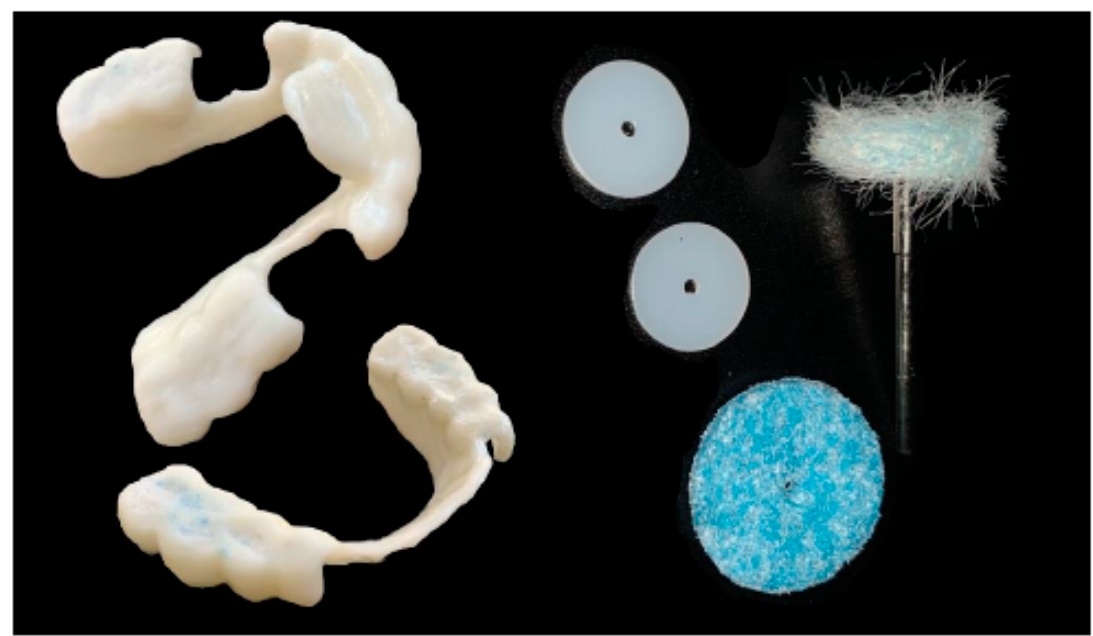
Figure 14. For any adjustments, only finishing tips should be used.